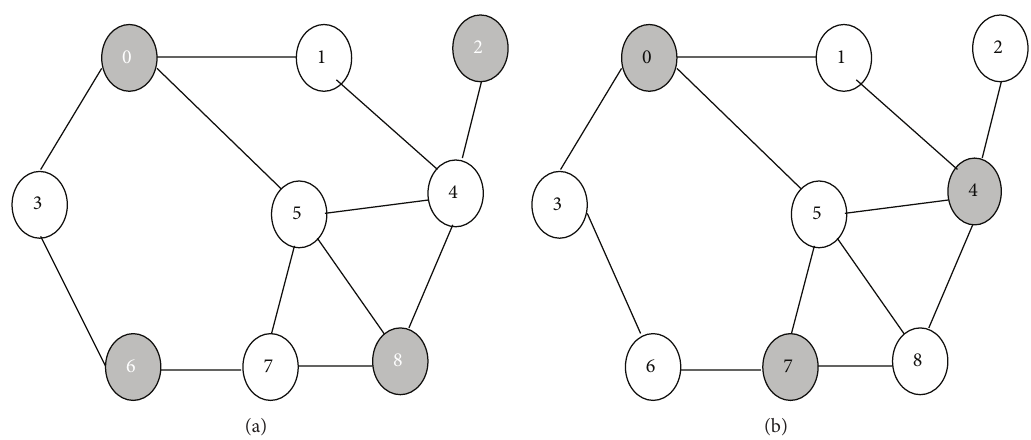
Figure 4: Figure 4(a) shows a DS with 4 CHs and Figure 4(b) shows a DS with 3 CHs.